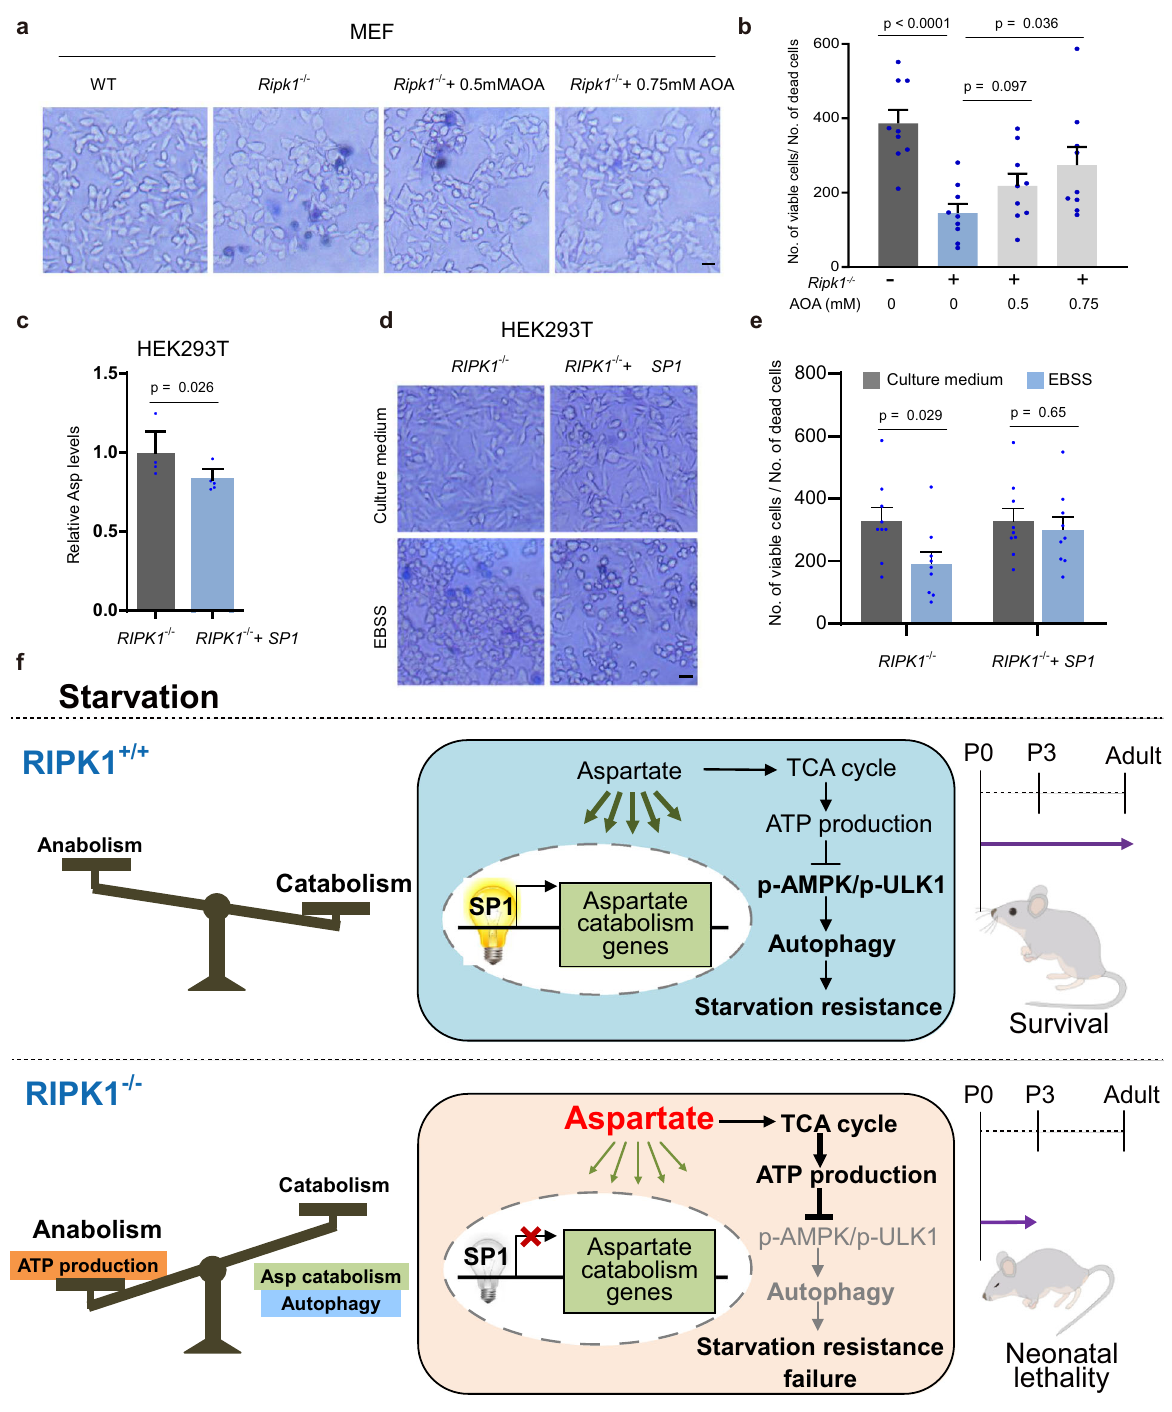
Fig. 8 Reduced aspartate levels rescue the survival of Ripk1 − / − cells from starvation. a , b Cell survival of Ripk1 − / − MEFs responding to AOA treatment was assessed by trypan blue exclusion. WT and Ripk1 − / − MEFs were cultured in EBSS for 6 h with 0.5 mM or 0.75 mM AOA treatment as indicated. Quanti fi cation of cell survival under different conditions was showed in ( b ). Data was expressed as the rate of viable cell number to dead cell number. Bars represent mean ± SEM ( n = 9, three biologically independent samples per group, three images in each biological repetition). Scale bar represents 10 μ m. P values were determined by one-way ANOVA by Tukey ’ s multiple comparisons test. c Intracellular aspartate levels in RIPK1 − / − HEK293T cells transfected with pcDNA-3.1 or pcDNA-3.1- SP1 plasmids were detected by LC – MS. Bars represent mean ± SEM ( n = 6 biologically independent samples per group). P values were determined by a two-tailed Student ’ s t -test. d , e Cell survival of RIPK1 − / − HEK293T cells responding to SP1 overexpression was assessed by trypan blue exclusion. Cells were transfected with pcDNA-3.1 or pcDNA-3.1- SP1 plasmids. The medium was changed to culture medium or EBSS for 6 h before harvest. Quanti fi cation of cell survival under different conditions was showed in ( d ). Data was expressed as the rate of viable cell number to dead cell number. Bars represent mean ± SEM ( n = 9; three biologically independent samples per group; three images in each biological repetition). Scale bar represents 10 μ m. P values were determined by a two-tailed Student ’ s t -test. f Graphical summary illustrating the role of RIPK1 in starvation